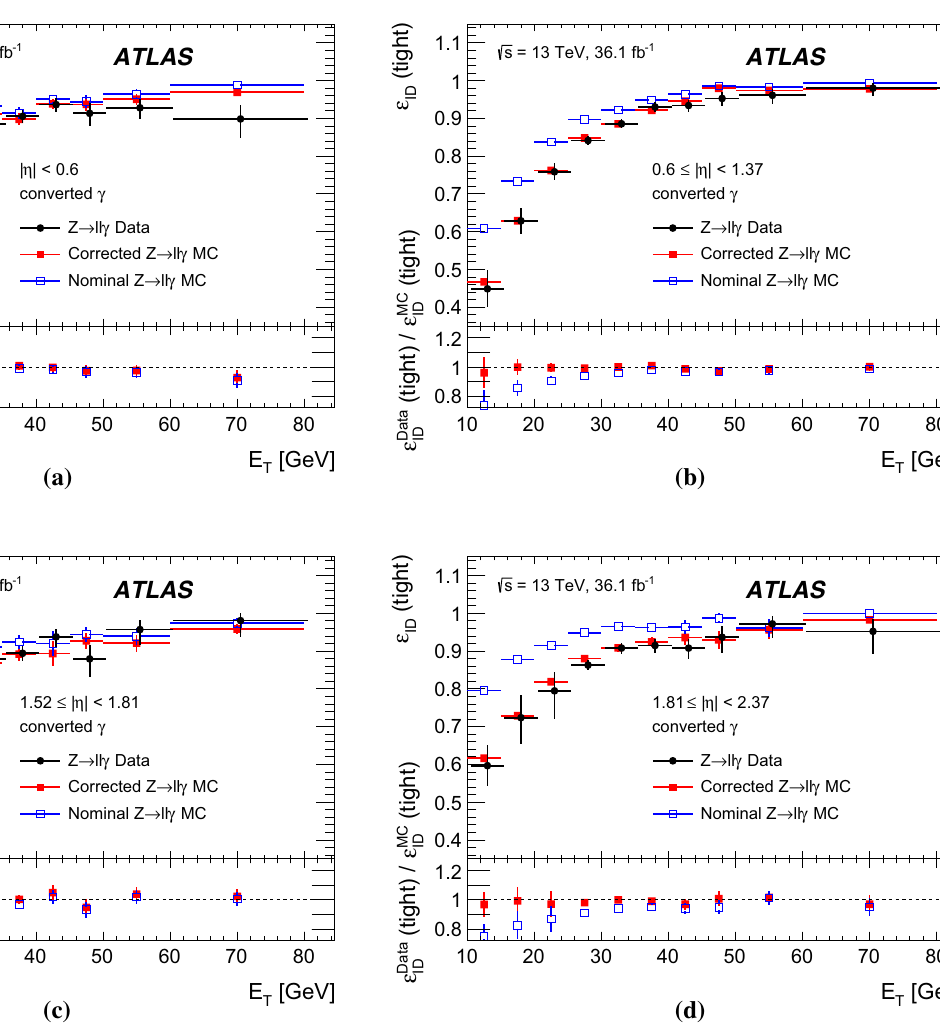
Predictions are shown for both the nominal simulation and with the cor- rections described in Sect. 4.1. The bottom panels show the ratio of the data-driven values to the MC predictions (referred to as scale factors in the